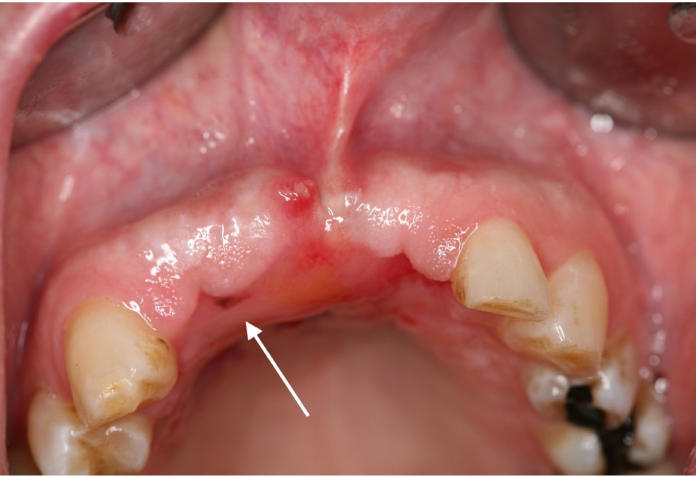
Figure 4. First recurrence of oral mucosal melanoma: in region 012, there was a 2 × 2 mm dark mucosal macule (white arrow), which was highly suspicious of a relapse of the OMM. The mass, including the adjacent parts of the alveolar ridge and the palatine bone, was resected once again. Histopathologically, a R0-resected recurrence (0.5 mm in all directions) of the previously known OMM in situ without bone infiltration was confirmed. After secondary granulation of the excision wound, two dental implants were inserted in regions 012 and 021 (Figure